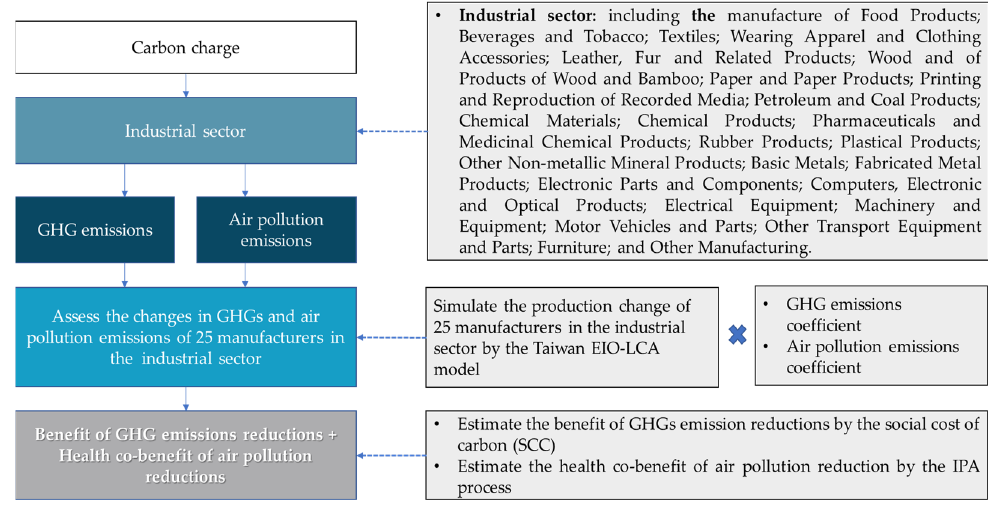
Figure 3. Framework of evaluation of benefits from GHG reduction and health co-benefits of air pollution reduction by means of the Taiwan EIO-LCA-EV model.